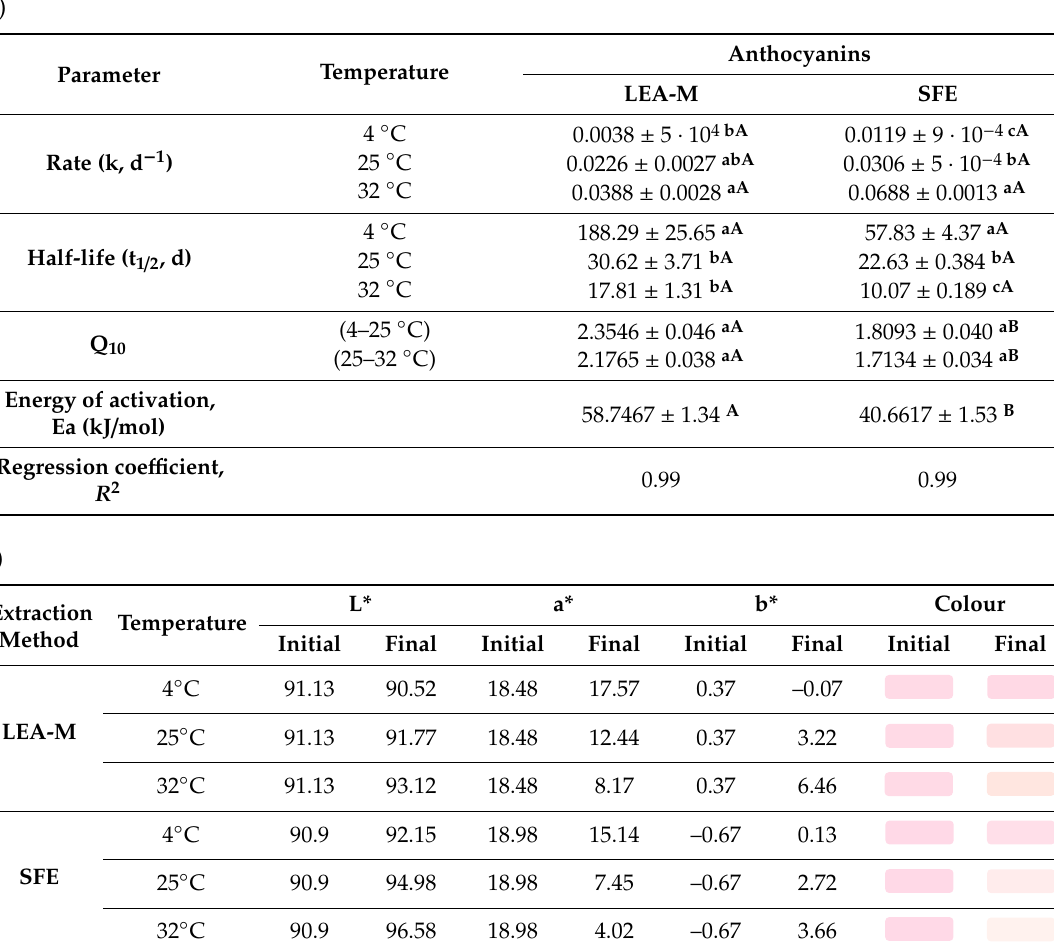
Q 10 : change in the reaction rate constant for 10 °C. Different lowercase letters show significant differences within the same sample at distinct storage temperature ( p < 0.05, Tukey HSD post hoc analysis), while different uppercase letters show significant differences among samples under the same storage temperature ( p < 0.05, two-sample t -test). The results are shown in mean ± standard error.